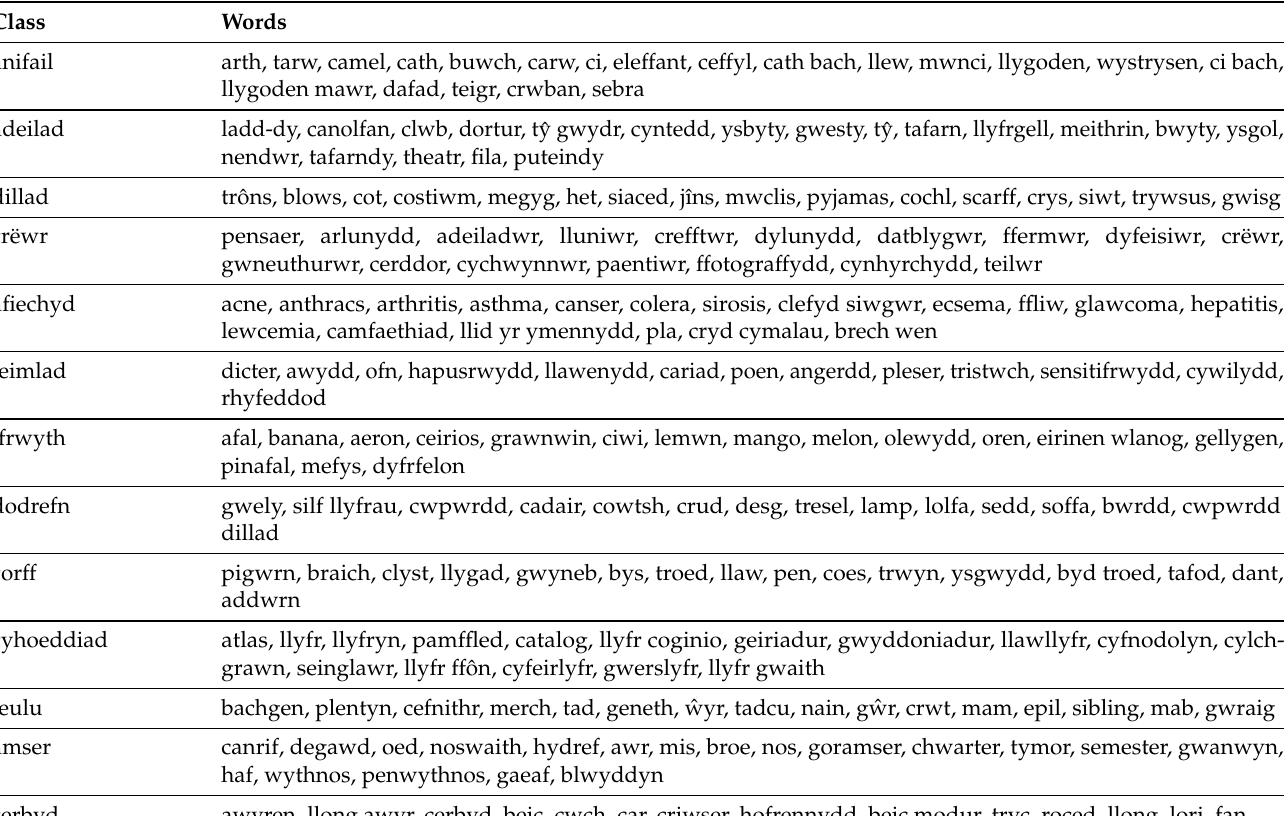
Table A1. Concept categorisation dataset.